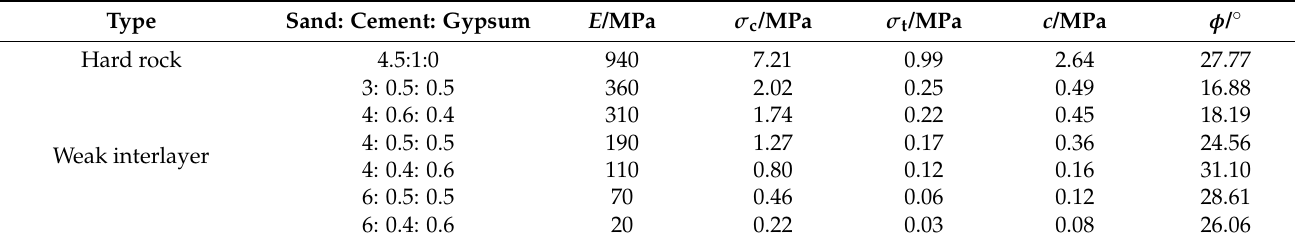
Table 2. Mechanical parameters of the similar